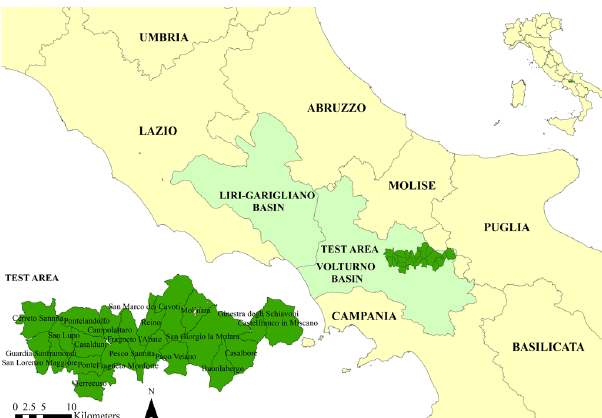
Fig. 1. The study